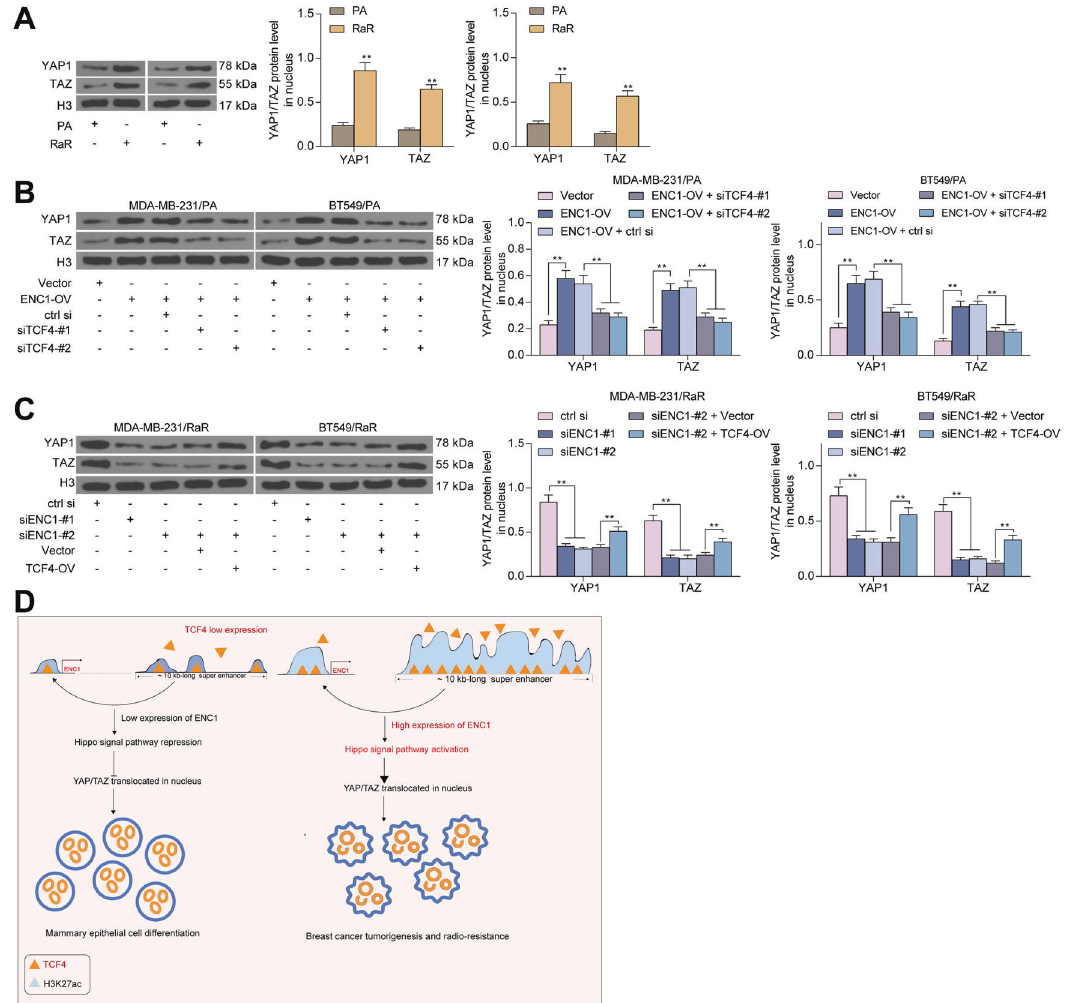
Fig. 8 ENC1 promotes the nuclear translocation of YAP1 with TAZ. A – C Western blot detection of YAP1 and TAZ nuclear translocation in untreated MDA-MB-231 and BT549 cells (A), MDA-MB-231/RA and BT549/RA cells ( B ) and MDA-MB-231/RaR and BT549/RaR cells ( C ). D ENC1 is driven by SE in BC, thereby promoting radio-resistance in BC cells. Data are representative of 3 separate experiments performed in triplicate. All the data are expressed as the mean ± SD. Two-way ANOVA with Tukey ’ s multiple comparison test were utilized to detect signi fi cant differences between data. ** p <